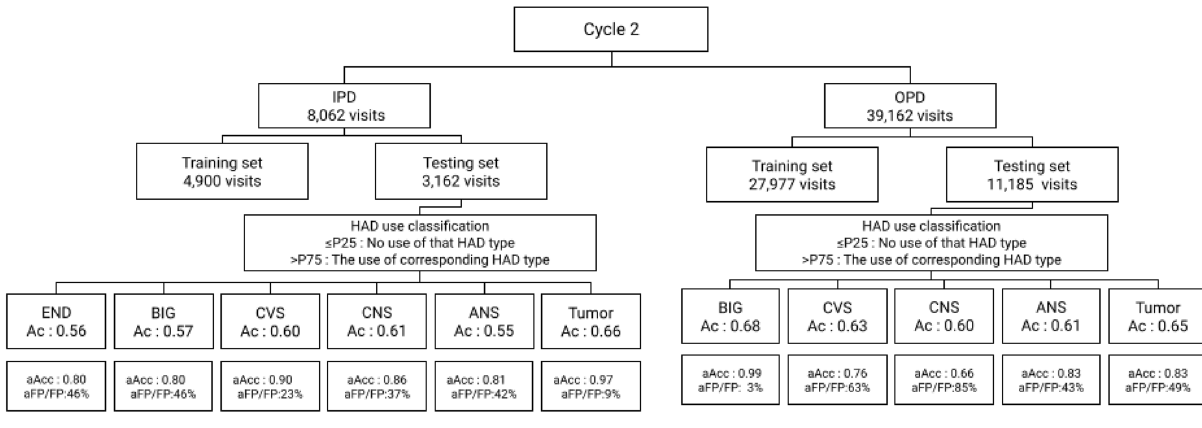
Figure 12. HAD classification result in Cycle